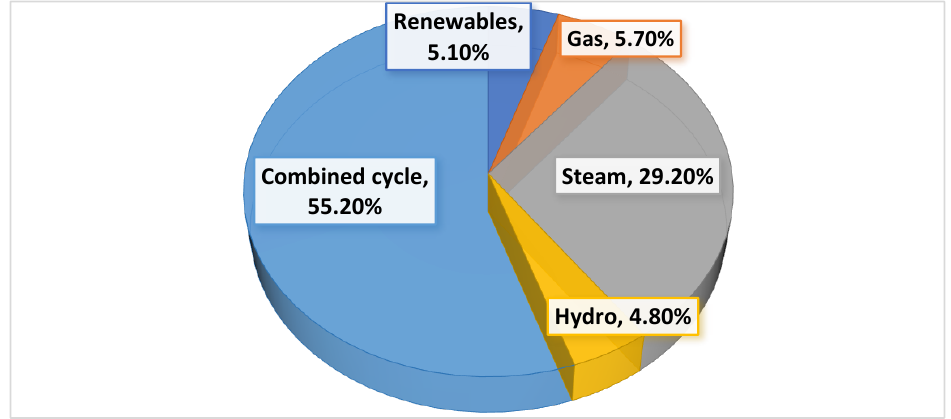
Figure 6. Primary energy consumption in Egypt.